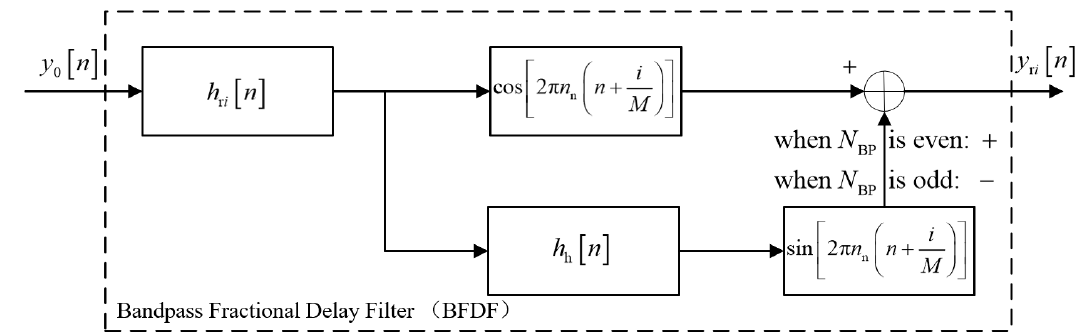
Figure 5. Bandpass fractional delay filter.